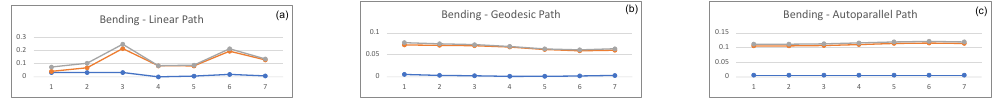
Figure 7. Non-affine case bending-only results. ( a ) Left panel: geodesic trajectory shapes (black) plotted against the original parametric shapes (red). ( b ) Center panel: geodesic trajectory shapes (black) plotted against the shapes found via linear interpolation between the first and last shapes of the parametric dataset (red). ( c ) Right panel: geodesic trajectory shapes (black) plotted against autoparallel trajectory (red) built via shooting of the first two configurations of the geodesic.